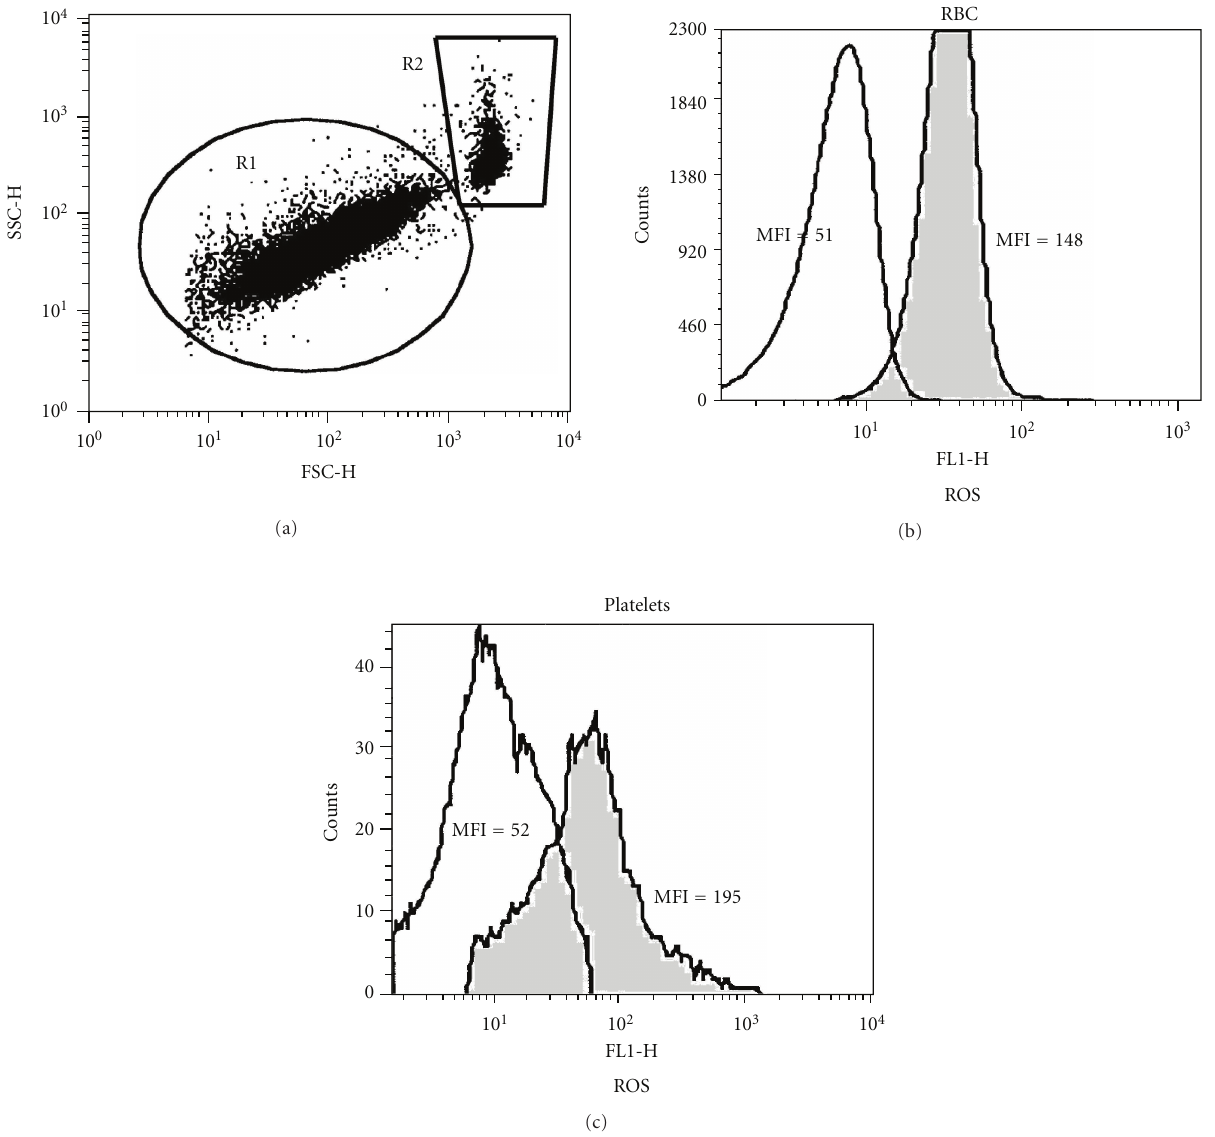
Figure 1: Flow cytometry analysis of the Epo e ff ect on ROS generation by RBC and platelets. A diluted blood sample obtained from a thalassemia patient was treated for 2 hrs with Epo (1U/ml) at 37 ◦ C, stained with DCF and then stimulated with 1mM H 2 O 2 for 15 min. (a) FCS versus SSC dot plot. The gates indicate the position of platelets (R1) and RBC (R2). (b-c) Distribution histograms showing DCF-derived fluorescence (FL-1) of untreated (grey) and Epo-treated (white) RBC (b) and platelets (c). The mean fluorescent intensity (MFI) of each population is